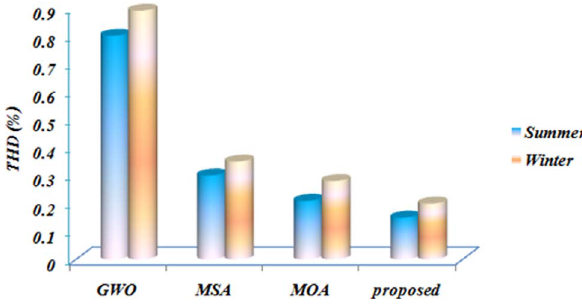
Figure 23. Analysis of statistical parameters of active power outlines in summer as well as winter.